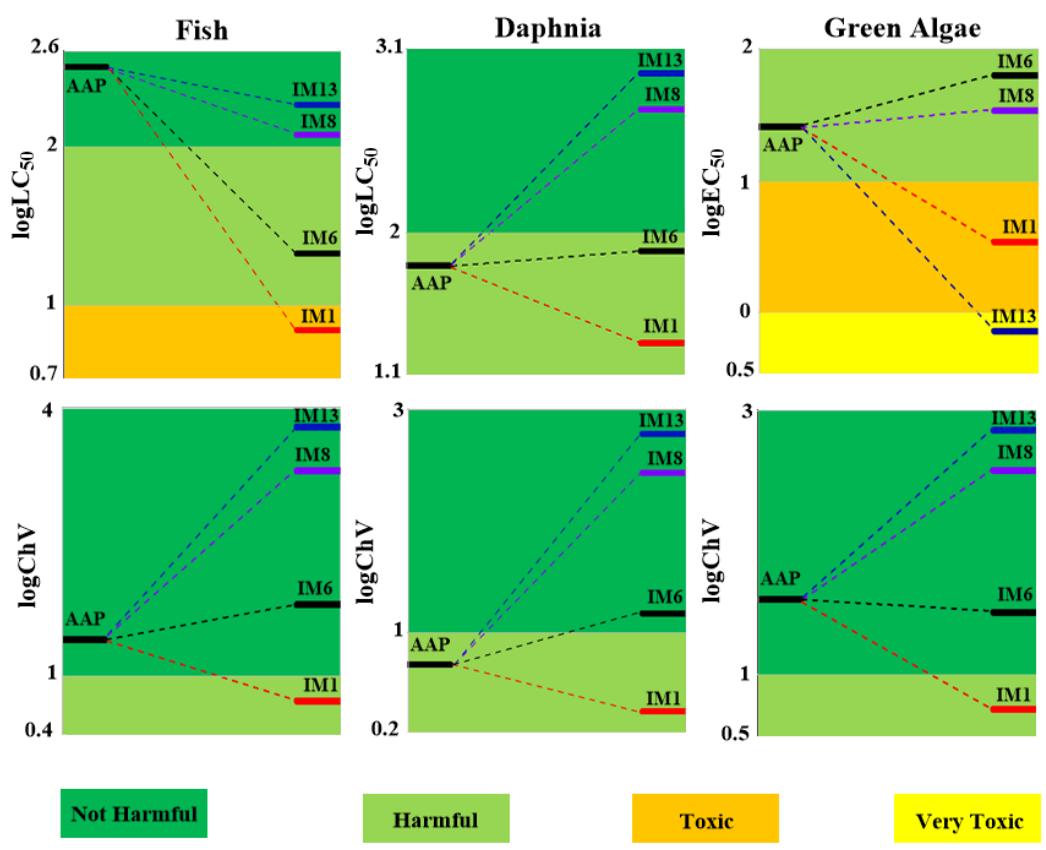
Figure 8. Acute and chronic toxicity (mg/L) of AAP and its transformation intermediates to aquatic organisms (fish, daphnia, and green algae).